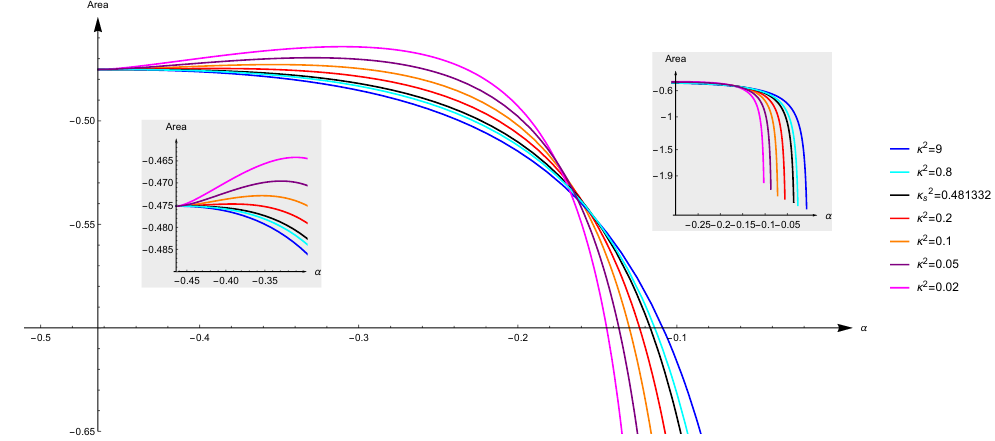
Figure 9. We have plotted the behaviour of the area as a function of (cid:11) = arctan( m ) for a (cid:12)xed value of the angle (cid:31) (below (cid:31) s ), but for di(cid:11)erent values of the (cid:13)ux. On the left we have zoomed the region close to the red curved boundary in (cid:12)gure 2. Independently of (cid:20) 2 all the curves terminate on the same point ( m 0 ; (cid:31) 0 = (cid:25) (cid:0) K ( m 0 )). For values of (cid:20) 2 (cid:20) (cid:20) 2 , this curve displays a maximum, s 2 instead they are monotonic if we are above the critical (cid:13)ux (cid:20) s . On the right we have plotted the same curves in the region close to m c = tan (cid:11) c , namely the value for which the distance from the brane vanishes. The area diverges for all value of the